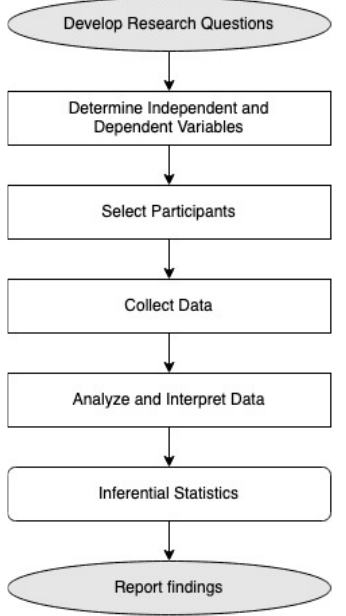
Figure 1. Process of casual-comparative design research.